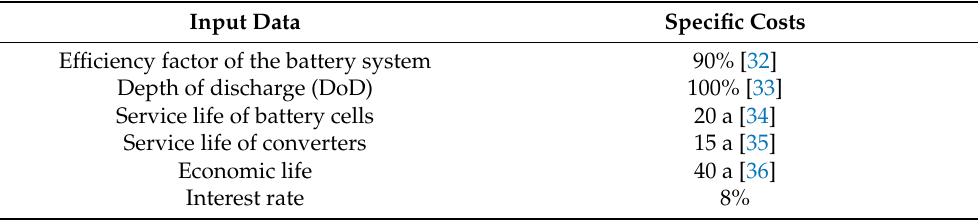
Table 8. Adopted assumptions for the cost calculation of